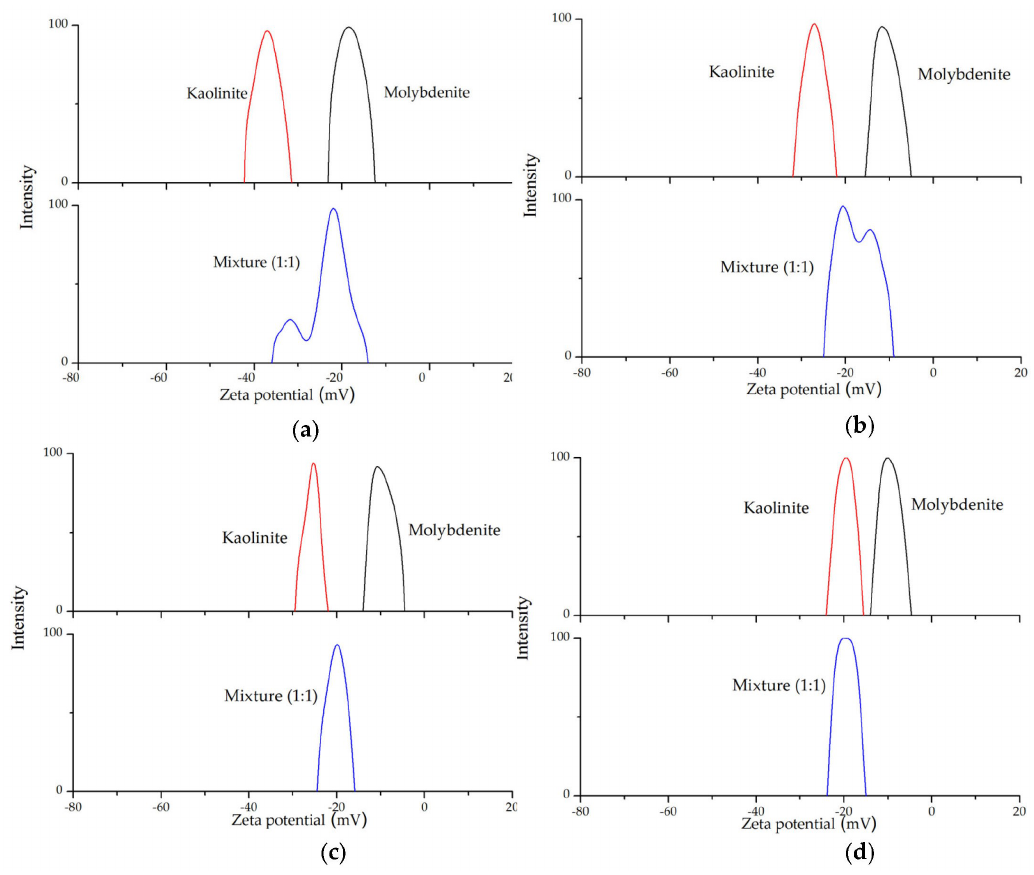
Figure 8. Zeta potential distributions of individual and mixed molybdenite–kaolinite with 1 mM KCl in ( a ) 200 mg/L gypsum solution; ( b ) 400 mg/L gypsum solution; ( c ) 600 mg/L gypsum solution; ( d ) 800 mg/L gypsum solution.